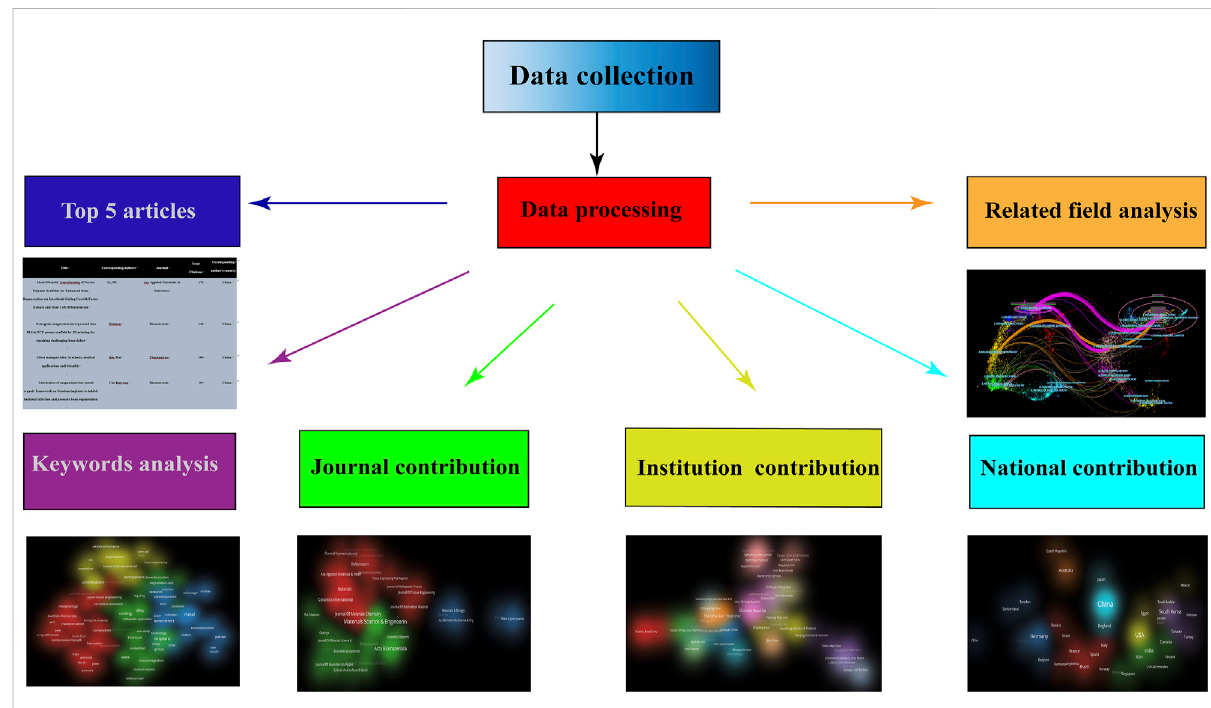
FIGURE 2 Flow diagram of the six studied aspects of metal materials and bone repair: contributions of countries, contributions of different journals, contributions of different institutions, the top 10 articles, keywords, and related fi elds.